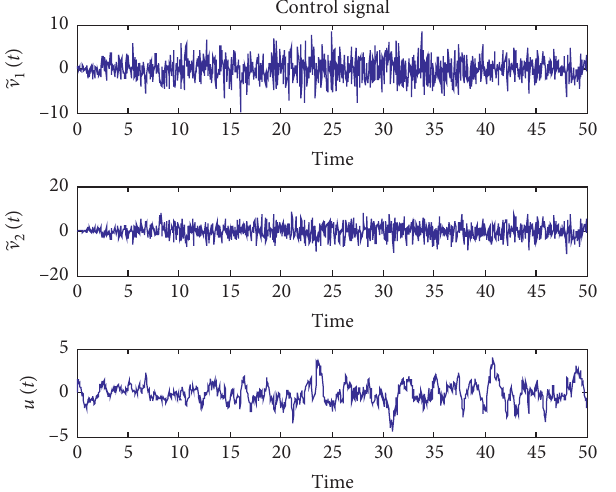
Figure 7: Control signals trajectories.